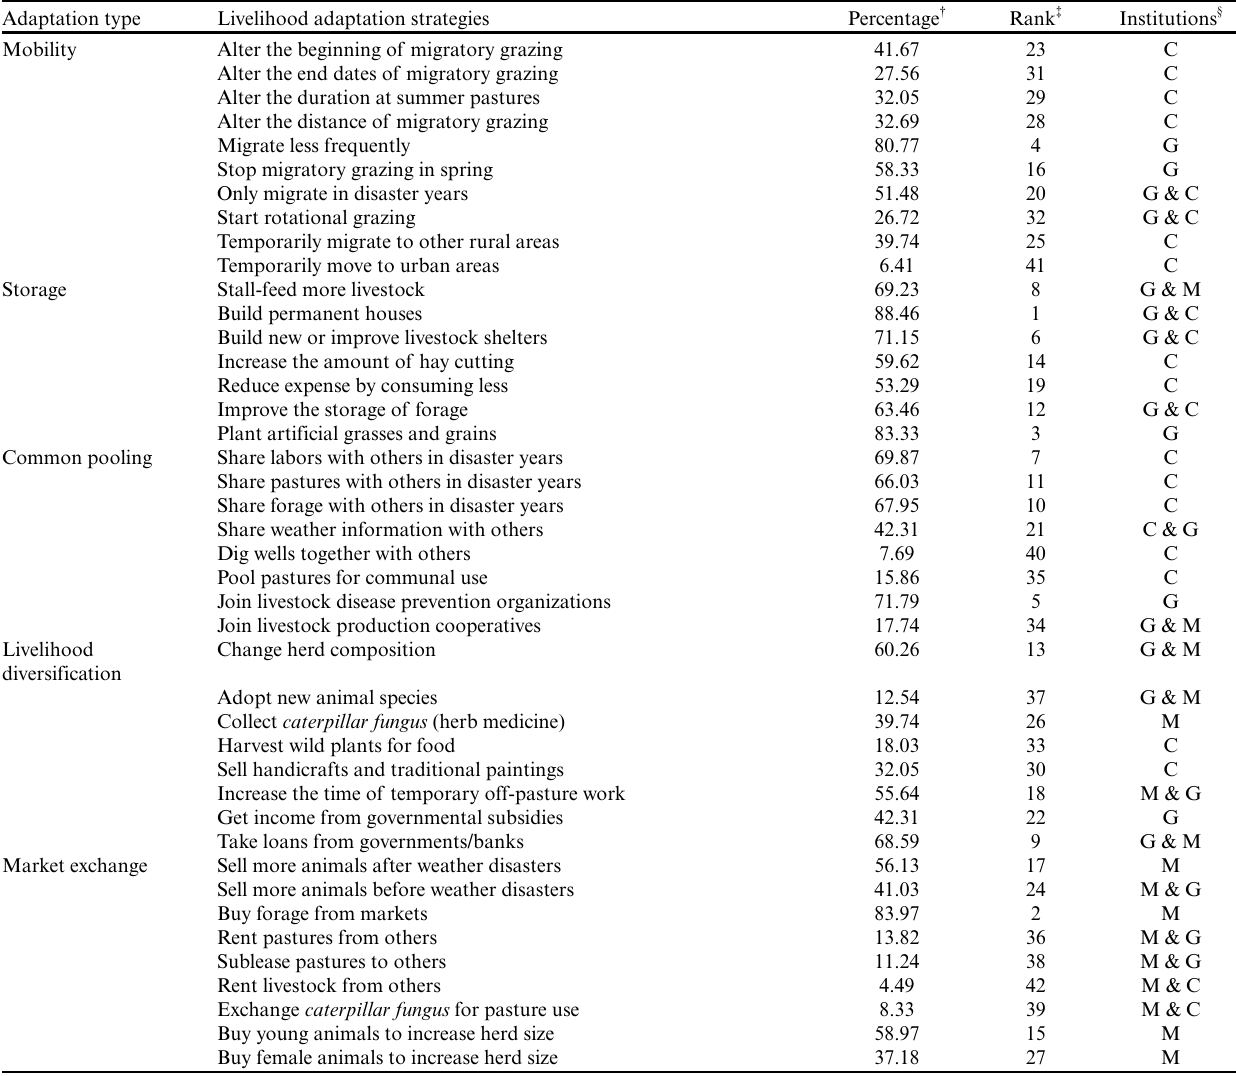
Table 2 . Livelihood adaptation strategies of herders and institutional facilitators in the surveyed